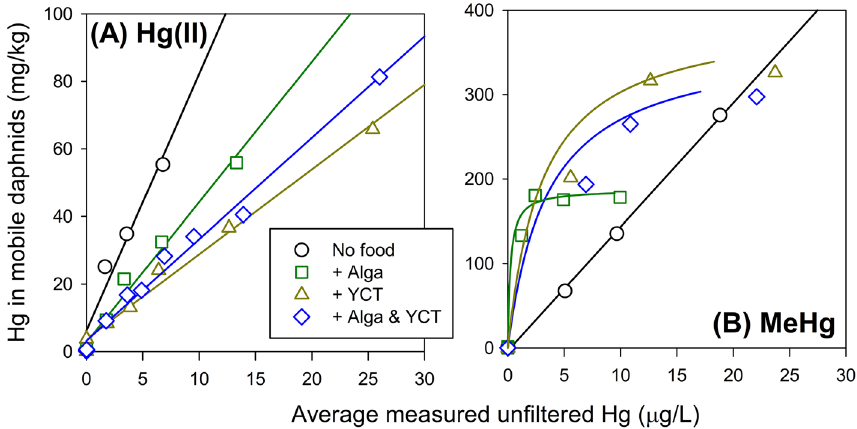
Figure 2. Biota concentrations of ( A ) inorganic Hg [Hg(II)] and ( B ) methylmercury (MeHg) in mobile (surviving) daphnids at the end of the 48-h acute toxicity tests under different treatments: No food; + Alga; + YCT; + Alga & YCT. See original data in the supplemental information file.